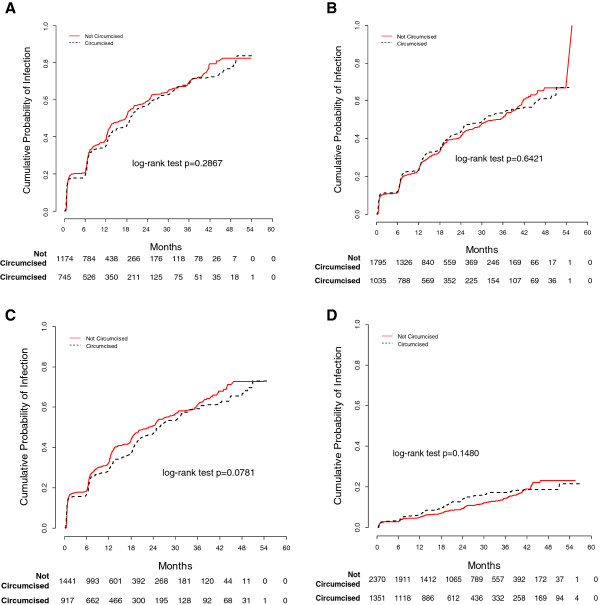
Kaplan-Meier estimates of the cumulative incidence of human papillomavirus (HPV) infections. Kaplan-Meier estimates of the cumulative incidence of human papillomavirus (HPV) infections for any HPV, oncogenic HPV, non-oncogenic HPV, and HPV 16 by male circumcision status: A) Incidence of any HPV; B) Incidence of oncogenic HPV; C) Incidence of non-oncogenic HPV; D) Incidence of HPV 16.